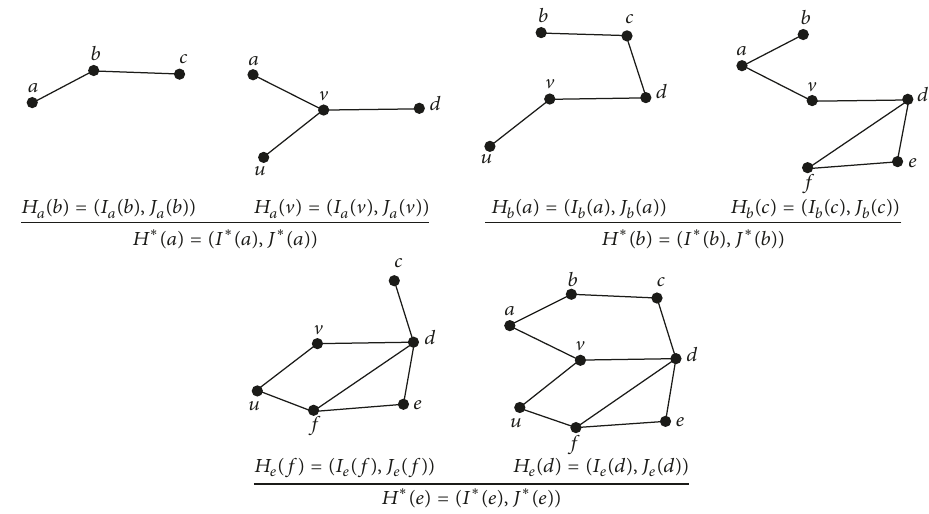
Figure 8: The 𝑢𝑛𝑖𝑜𝑛 of 𝐺 ∗ and 𝐺 󸀠∗